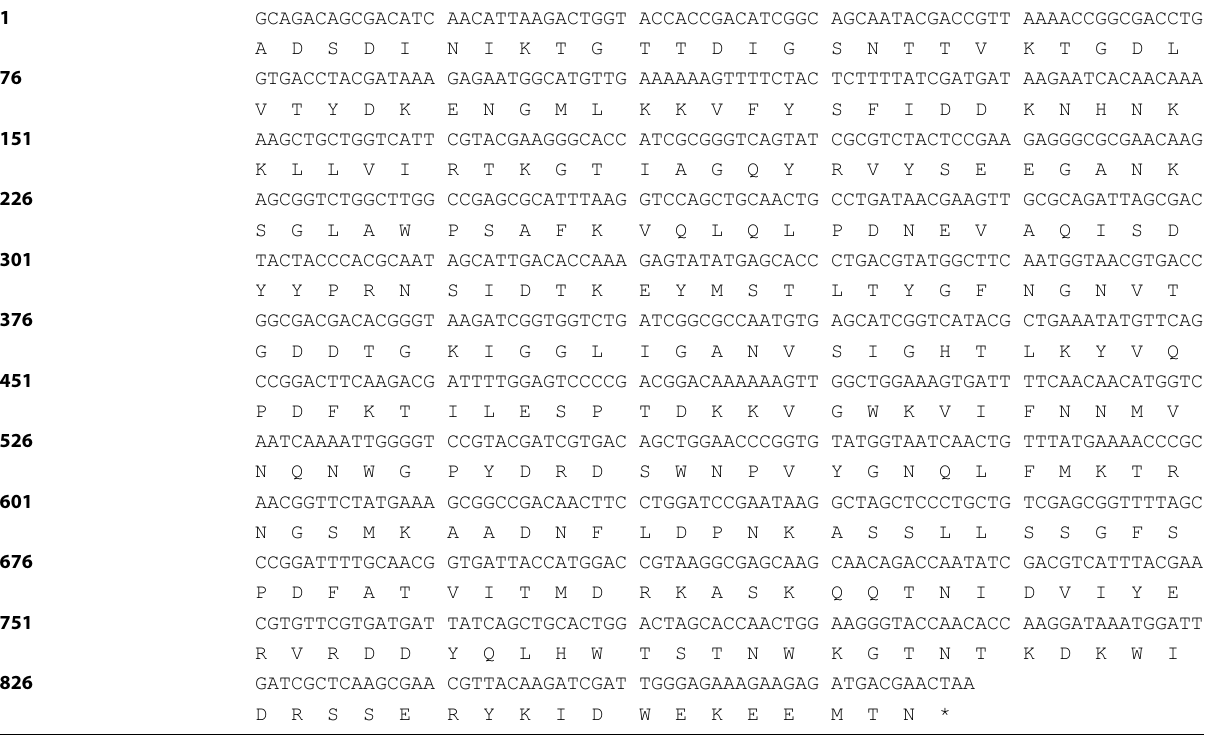
used in this study (Gene bank accession no. KY474302) H35L